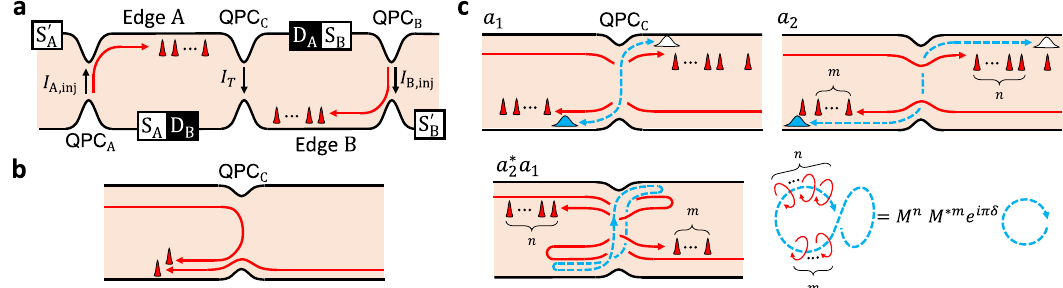
Fig.1|FractionalquantumHallcollider.a Setup.AnyonsareinjectedtoEdgeA/B through QPC A/B by voltage V A/B,inj applied to Source S A/B , accompanied by current e * . The injected anyons (red narrow peaks) fl ow downstream to I A/B,inj of charge QPC C (red trajectories); a corresponding setup for upstream anyons is shown in Fig. 2. The QPCs are in a weak backscattering regime. b Conventional collision where an injected anyon collides with another after tunneling at QPC C . c Time- domain interferenceinvolving ( n , m ) braiding.Its subprocesses a 1 and a 2 share the common spatiallocations of injectedanyons on the Edges. They have tunneling